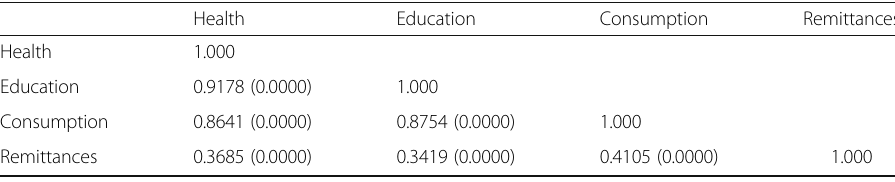
Table 5 Correlation test for HEWE components